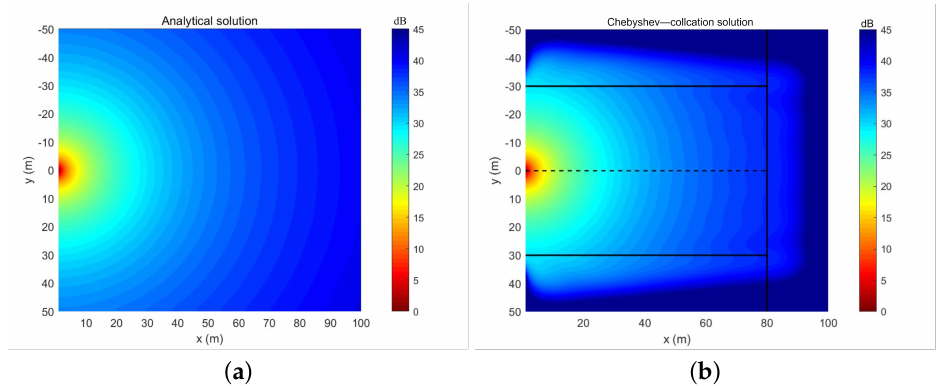
Figure 2. TL field of a spherical wave: the result of the analytical solution ( a ); the result of the collocation method ( b ).